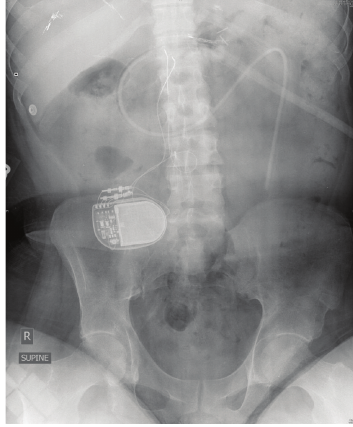
Figure 3: Supine radiograph demonstrating G-J tube in normal